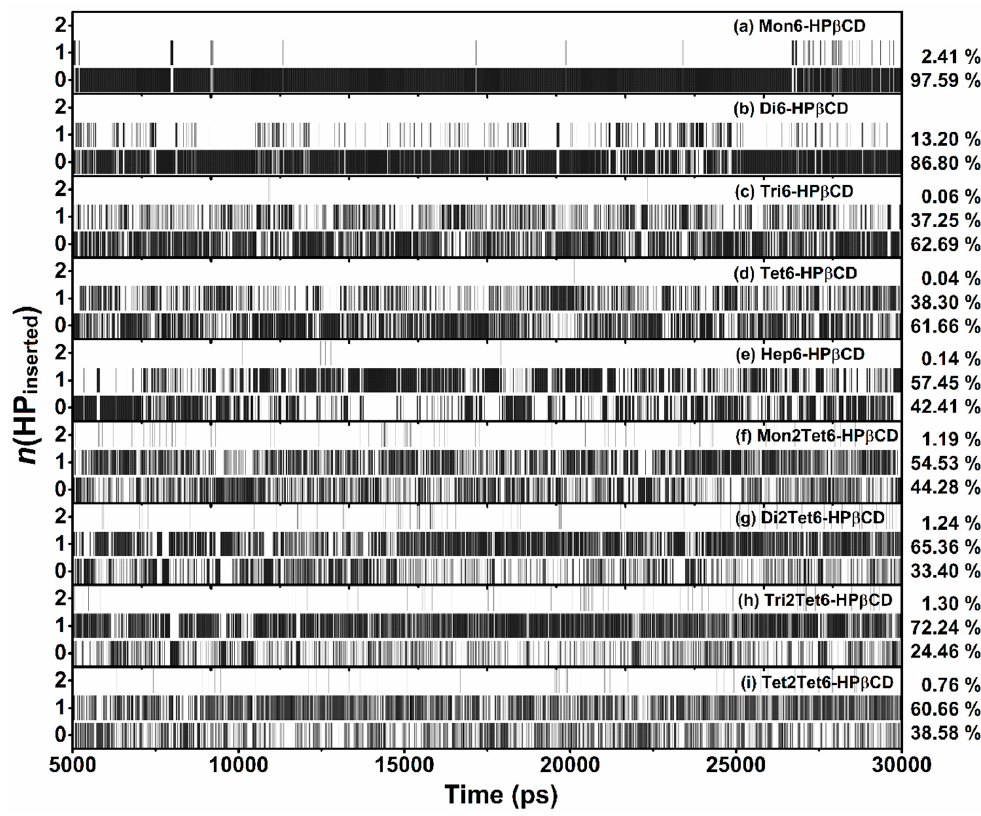
Figure 8. The probability of n (HP inserted ) from 25,000 snapshots (criteria: d 4(i) [C g( β CD) –C g(HP(i)) ] < 3 Å) at 300 K for all HP β CDs.